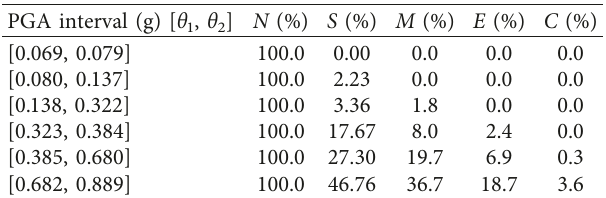
Table 7: Belief measure of damage subsets in equation (16) using equation (3) based on the degree of belief m in Table 3.